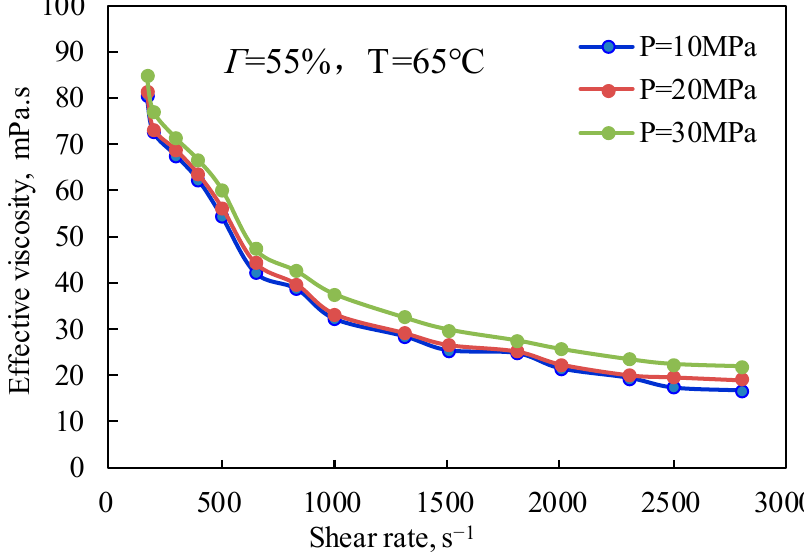
Figure 10. Variation of effective viscosity with shear rate under different pressures (foamed).